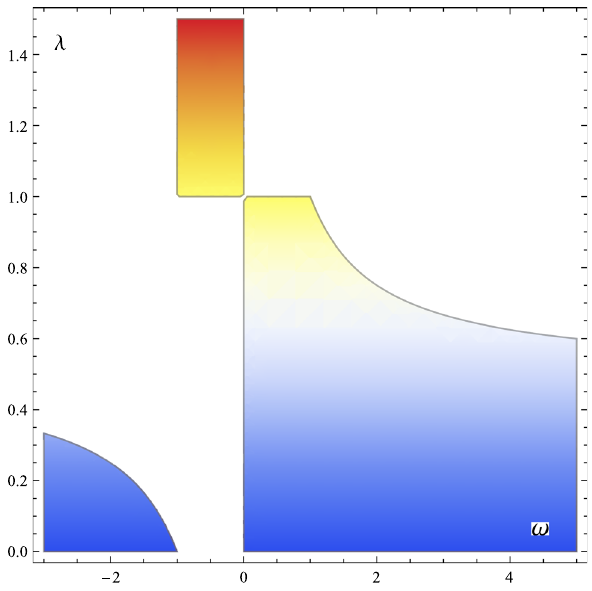
Fig. 1 Parameter space ( ω , λ ) associated to the modified wormhole solution due to Lorentz breaking. The colored regions indicate the allowed values of these parameters for the formation of the wormhole. Hot (cold) colors indicate great (small) values for the Lorentz break- down parameter,